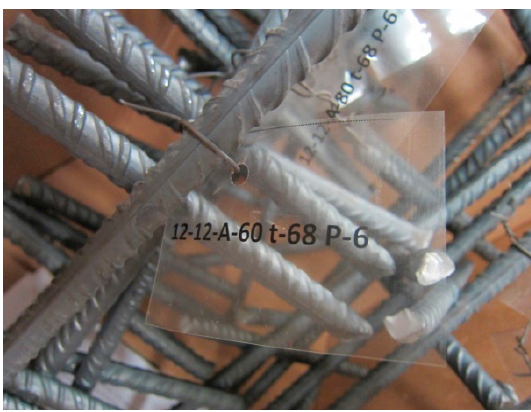
Figure 5. Label nomenclature of the joint thickness (12+12=24 mm).